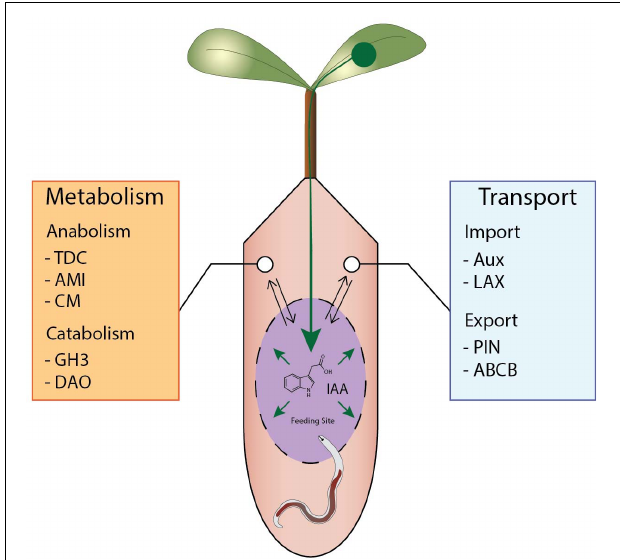
FIGURE 5 | Overview of potential mechanisms leading to IAA accumulation during nematode feeding sites formation. A schematic feeding site is depicted in purple with auxin flows shown in green. IAA accumulates due to regulation of auxin transport redirecting IAA to the feeding site from the vascular bundle. In addition, local IAA synthesis occurs in and/or around the feeding site while auxin catabolism is